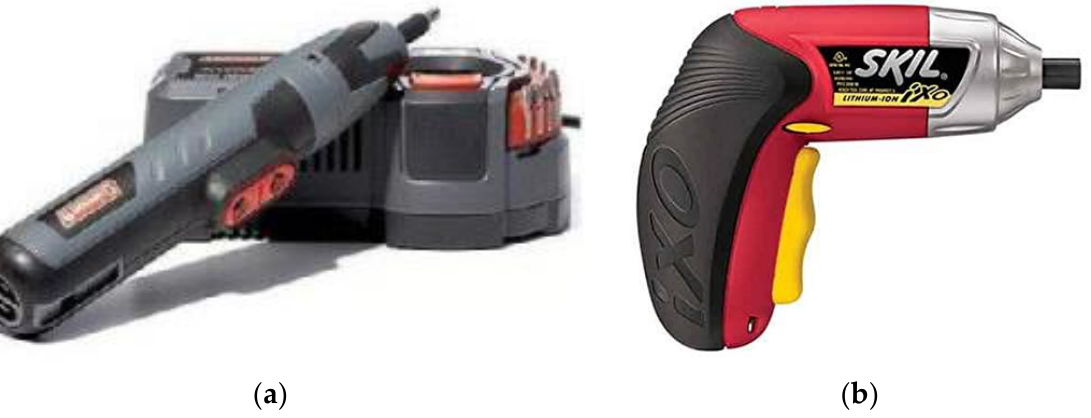
Figure 11. Cordless screwdrivers: ( a ) Coleman 5.4 V Flash-Cell ultracapacitor driven screwdriver, ( b ) SKIL 2336-02 iXO 3.6 V Lithium-ion battery driven screwdriver.